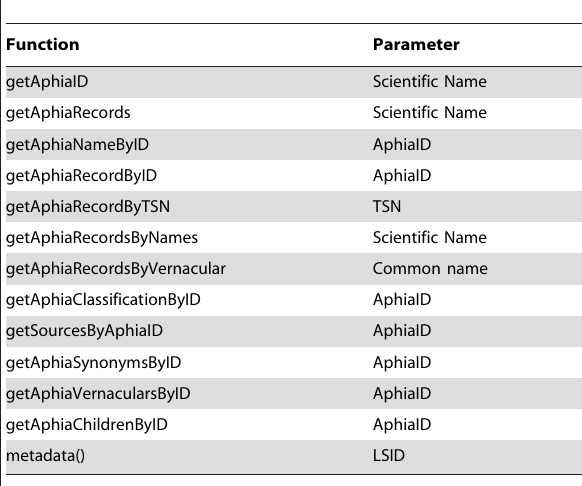
Table 6. Examples of possible applications of the WoRMS web